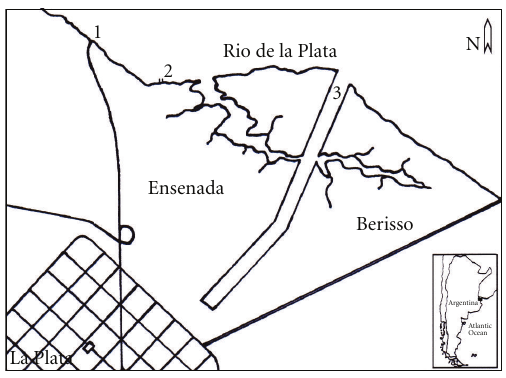
Figure 1: Estuary area sampling sites. Station 1: main intake of La Plata City water treatment plant, Station 2: the harbor access, and Station 3: a recreational river